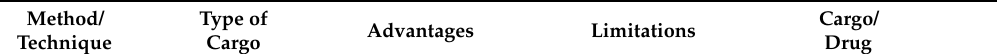
Table 2. A summary of different cargo loading